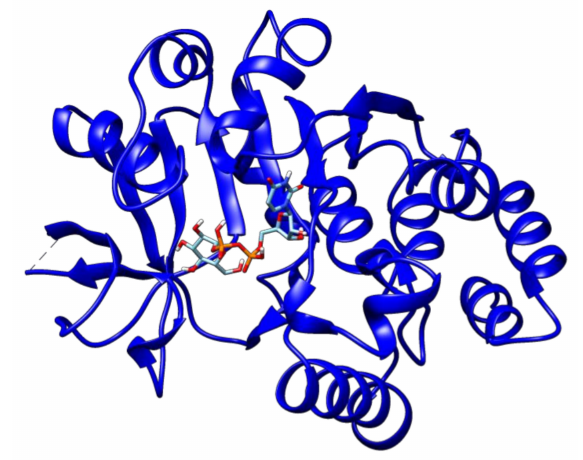
Figure 4. The docked complex of uridine diphosphate glucose and glucose-1- phosphate thymidylyltransferase.